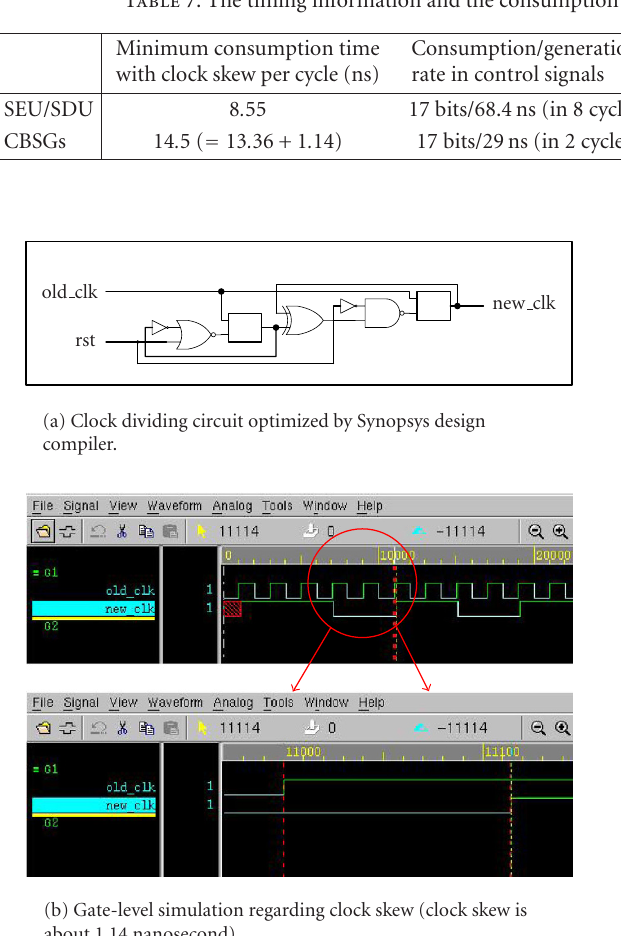
Figure 8: Clock dividing circuit and the associated gate-level simulation results regarding clocks (CLK SEU / SDU = old clk and CLK CBSG = new clk) in the proposed design.